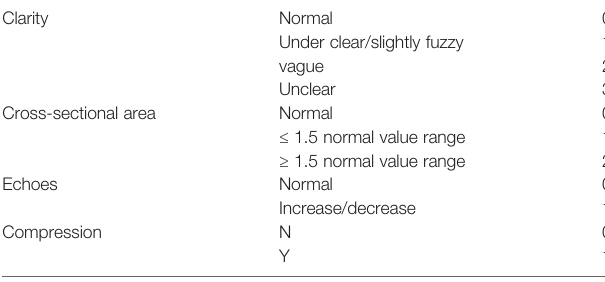
TABLE 5 | DCEC scoring rules DCEC scoring rules.